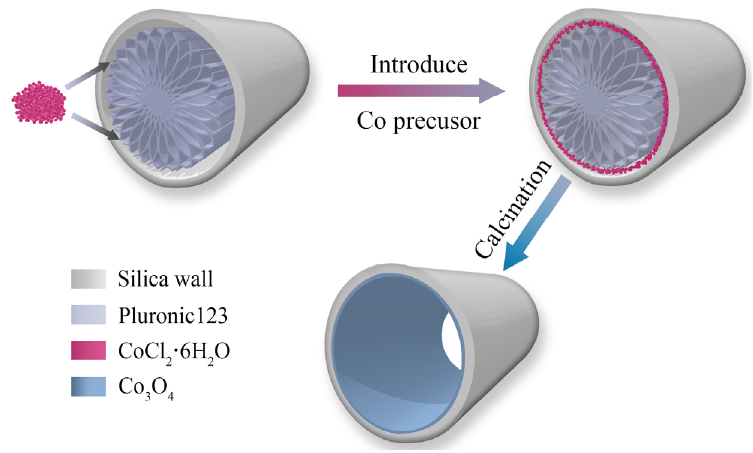
Figure 1. Schematic diagram of the synthetic process for Co–SiO 2 catalysts.